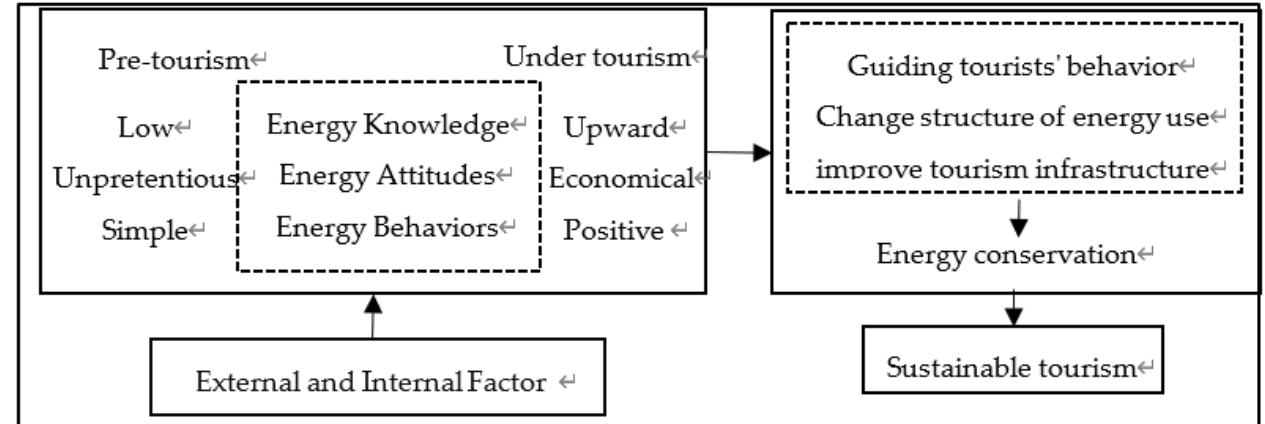
Figure 2. Conceptual Framework of the relationships between energy literacy and sustainable tourism (Source: by own study).